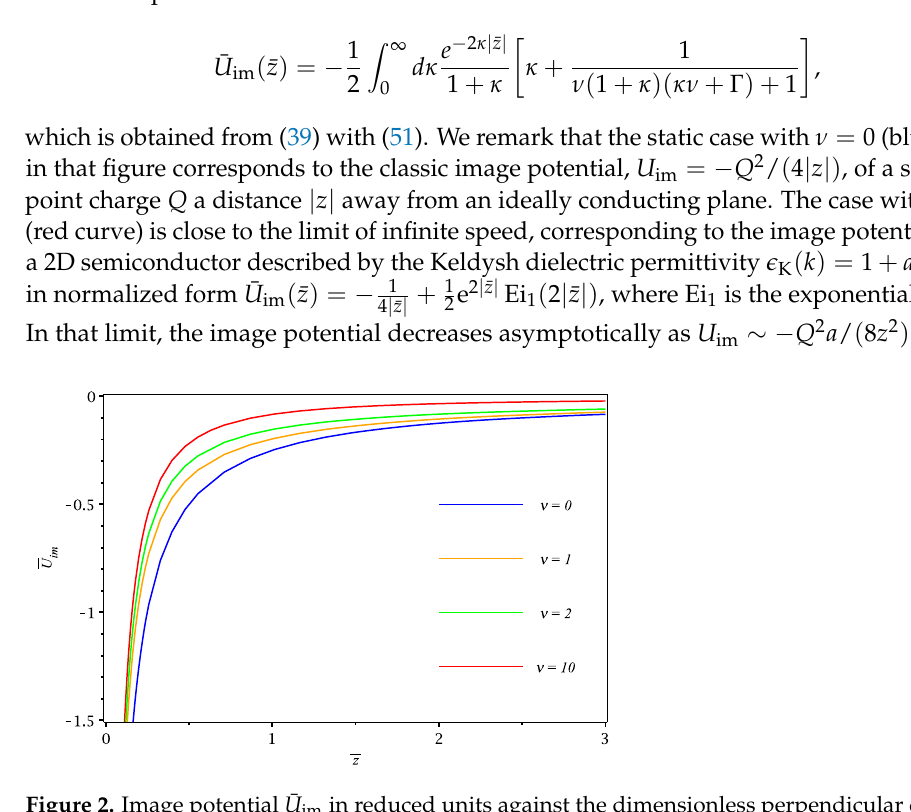
Figure 2. Image potential ¯ U im in reduced units against the dimensionless perpendicular distance ¯ z for different reduced speeds ν with damping parameter Γ =